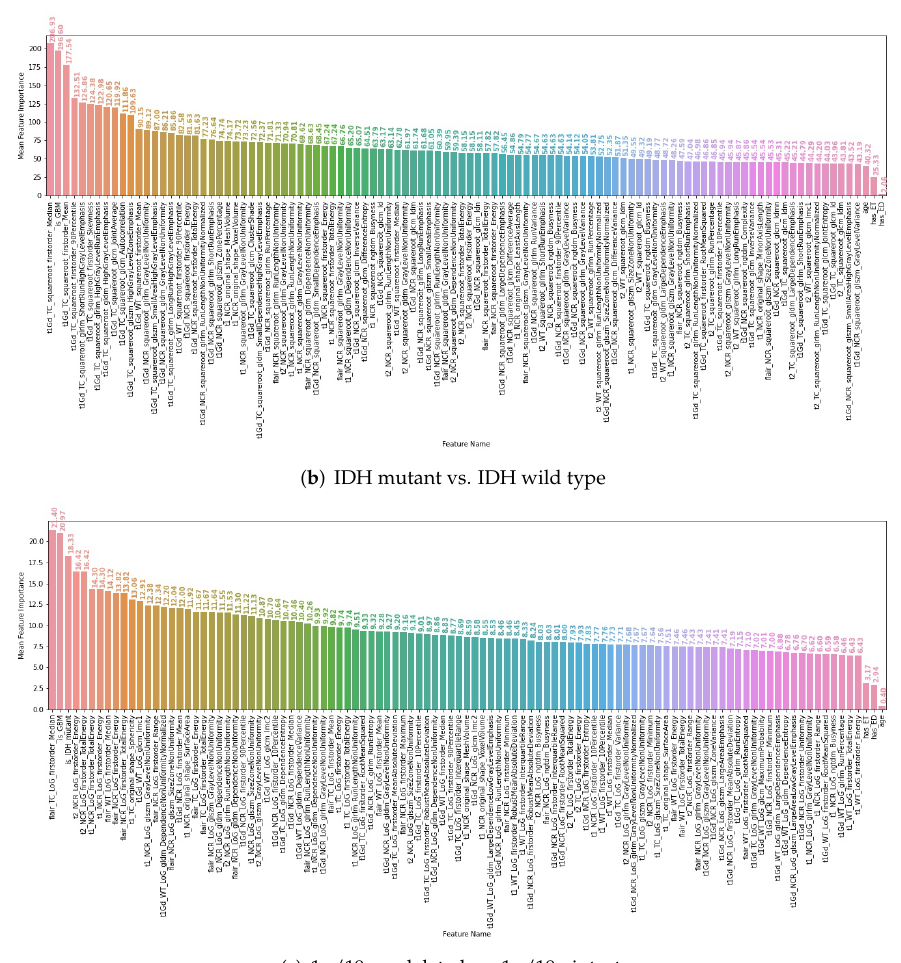
Figure 13. The non-radiomic features and the first 100 radiomic features with the highest average feature importance calculated by the ANOVA F-value for predicting ( a ) tumor grade, ( b ) IDH mutation status, and ( c ) 1p/19q codeletion status. The feature importance annotated on each feature bar refers to the mean feature importance averaged on the 51 random